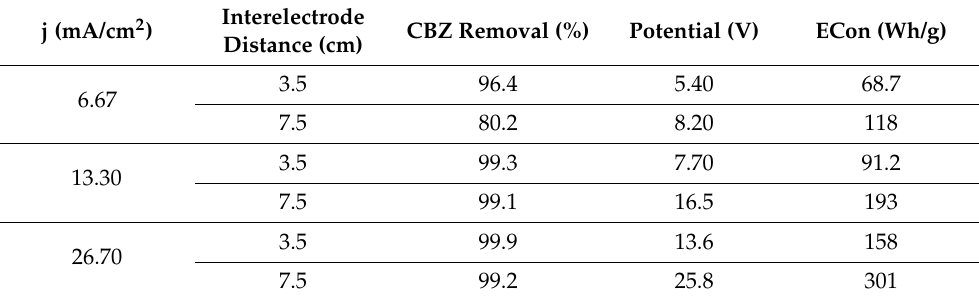
Table 2. Current density, interelectrode distance, CBZ removal (%), potential, and energy consump- tion for the 2D electrochemical removal of CBZ from aqueous solutions using an MMO anode and an STS